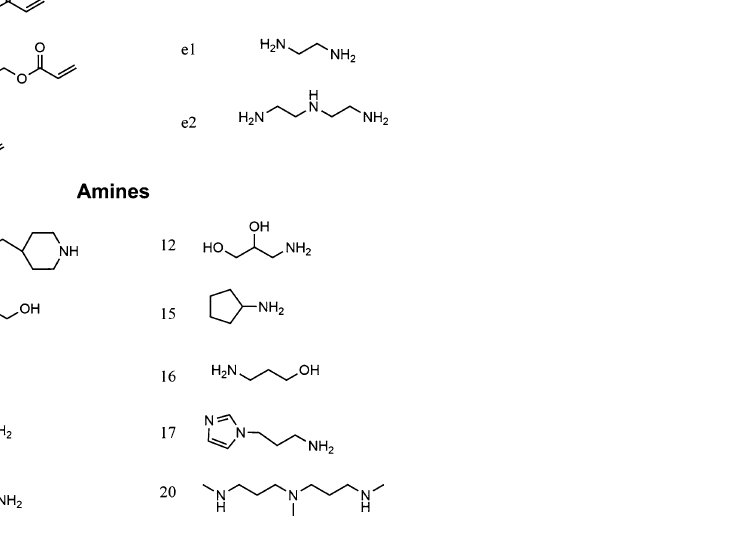
Figure 2. Structure and coding of constituents of PBAEs library